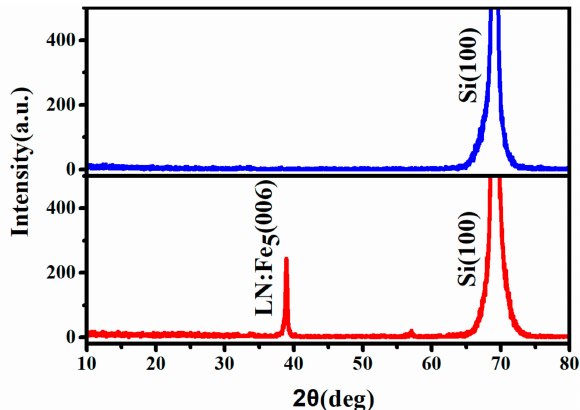
Figure 2. X-ray di ff raction (XRD) patterns for LN:Fe 5 / Si p-n junction, the di ff raction peak (above) at 2 θ = 69.1 ◦ corresponds to the Si(100) substrate and the peaks labeled LN:Fe 5 (006) and Si(100) (below) correspond to LN:Fe 5 thin film at 2 θ = 39.1 ◦ and Si substrate 2 θ = 69.1 ◦